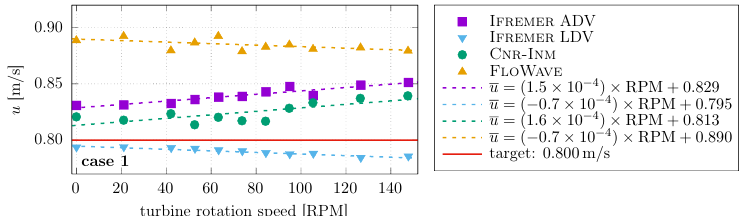
Figure 9. Variation of the time-averaged (markers) and linear regression (dotted lines) of the ADV and LDV (only at I FREMER ) stream-wise velocity u in synchronisation with the turbine against the turbine rotational speed for case 1 at all facilities. The red line indicates the target velocity of 0.8 m/s.